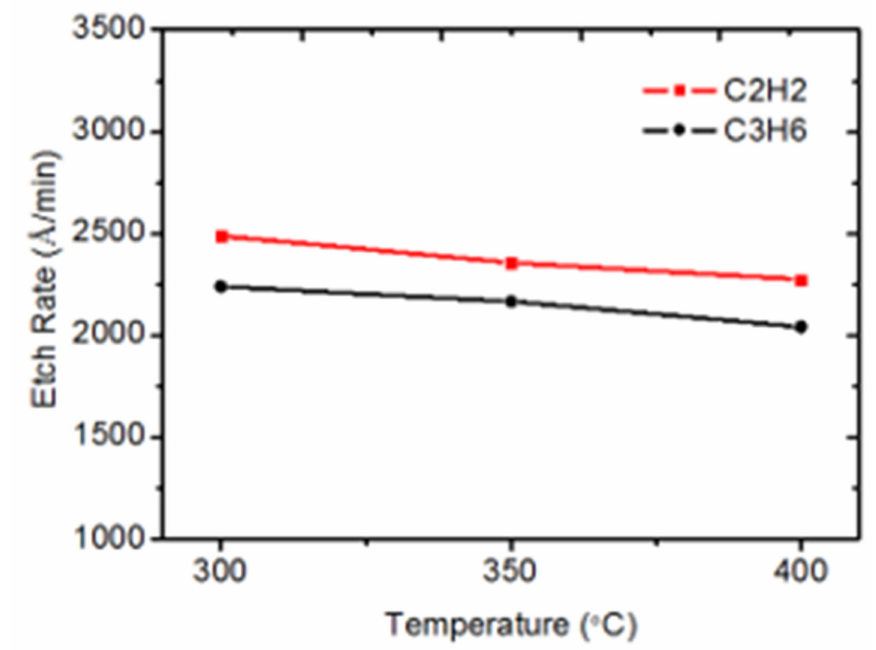
Figure 4. Dry etch rate as a function of deposition temperature.